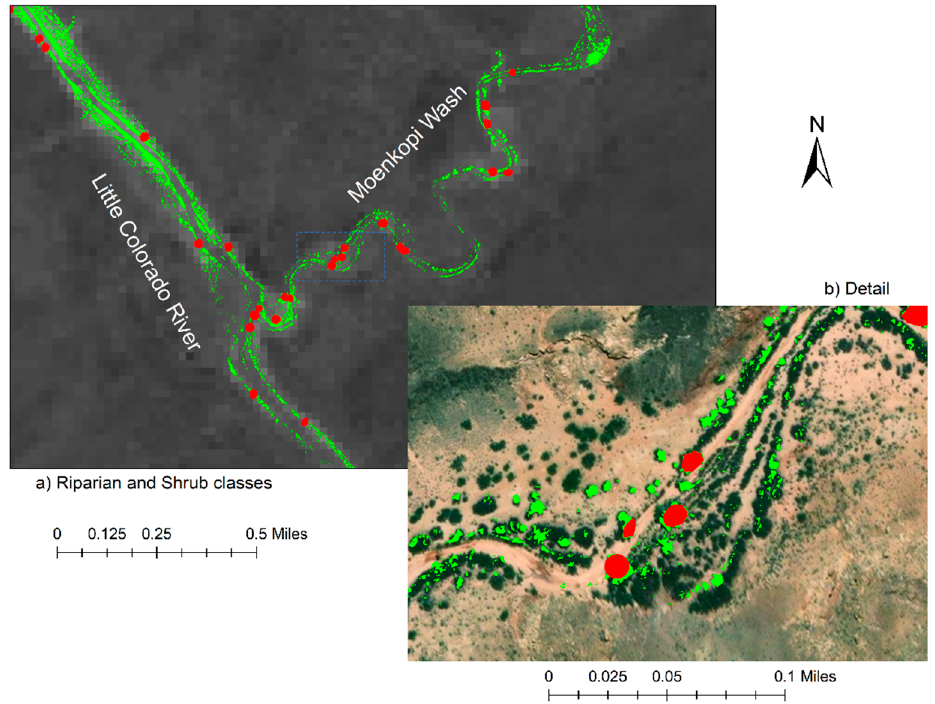
Figure 3. Digitization at two zoom levels depicting the vector-based method of delineating riparian shrubs (light green) and trees (red) along a selected portion of the Little Colorado River watershed based on a single summer 2019 National Agricultural Imagery Program (NAIP) image.